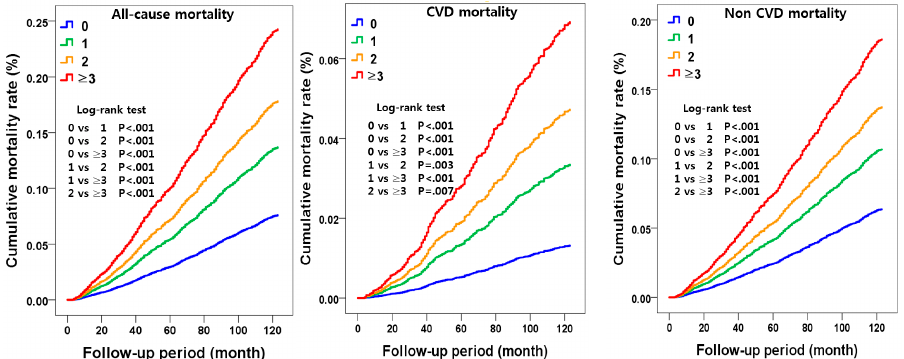
Figure 1. The Kaplan-Meier survival curves for all-cause and CVD and non CVD mortality according to a number of lifestyle risk factors.